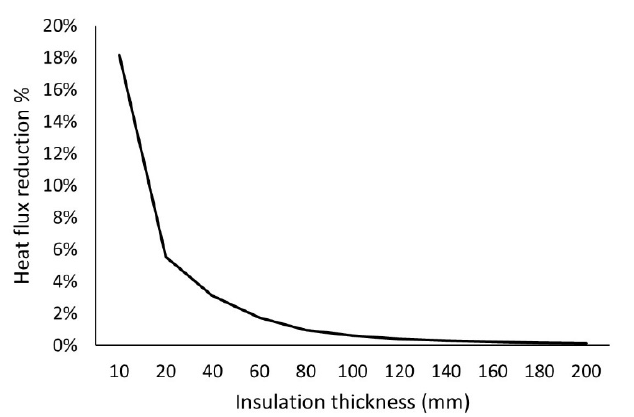
Figure 17. Percentage of heat flux reduction of using external insulation with regard to the insula ‐ tion thickness.